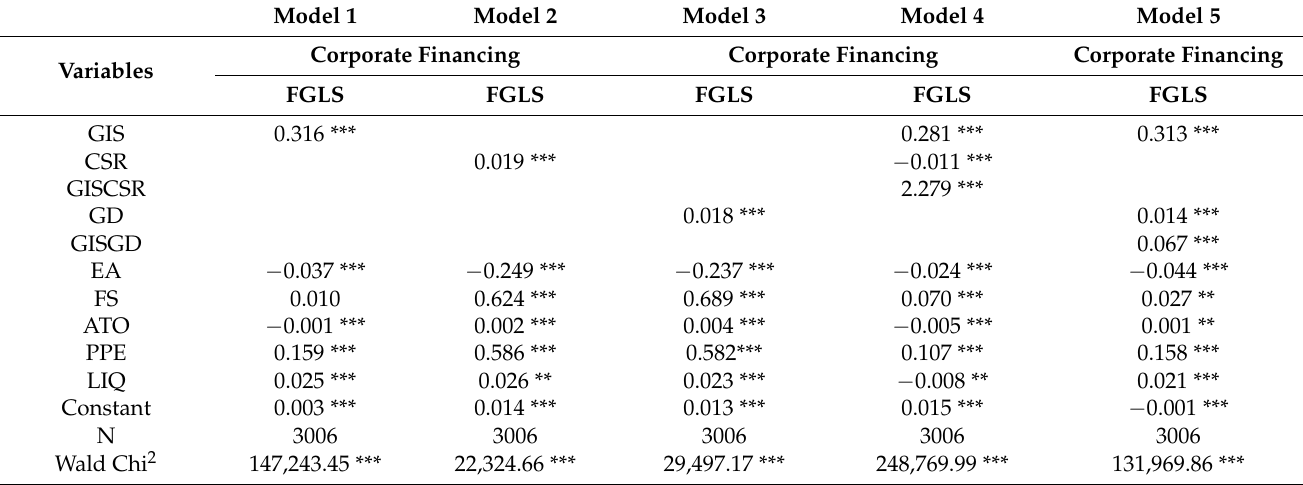
Table 4. The robustness results with